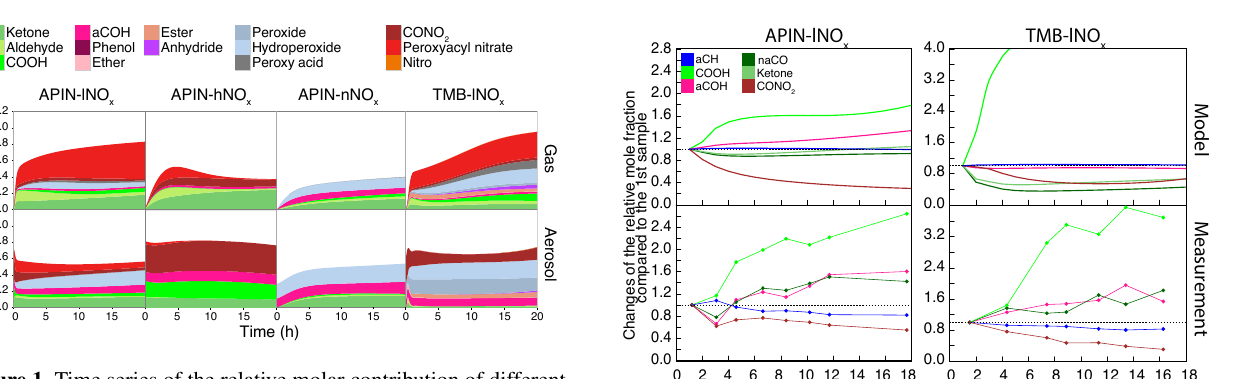
Figure 1. Time series of the relative molar contribution of different FGs to the O:C in the gas phase (top panels) and aerosol phase (bot- tom panels) simulated in this work for APIN-lNO x , APIN-hNO x , APIN-nNO x , and TMB-lNO x . The contribution of each FG to the O:C ratio accounts for the number of oxygen atoms per FG.